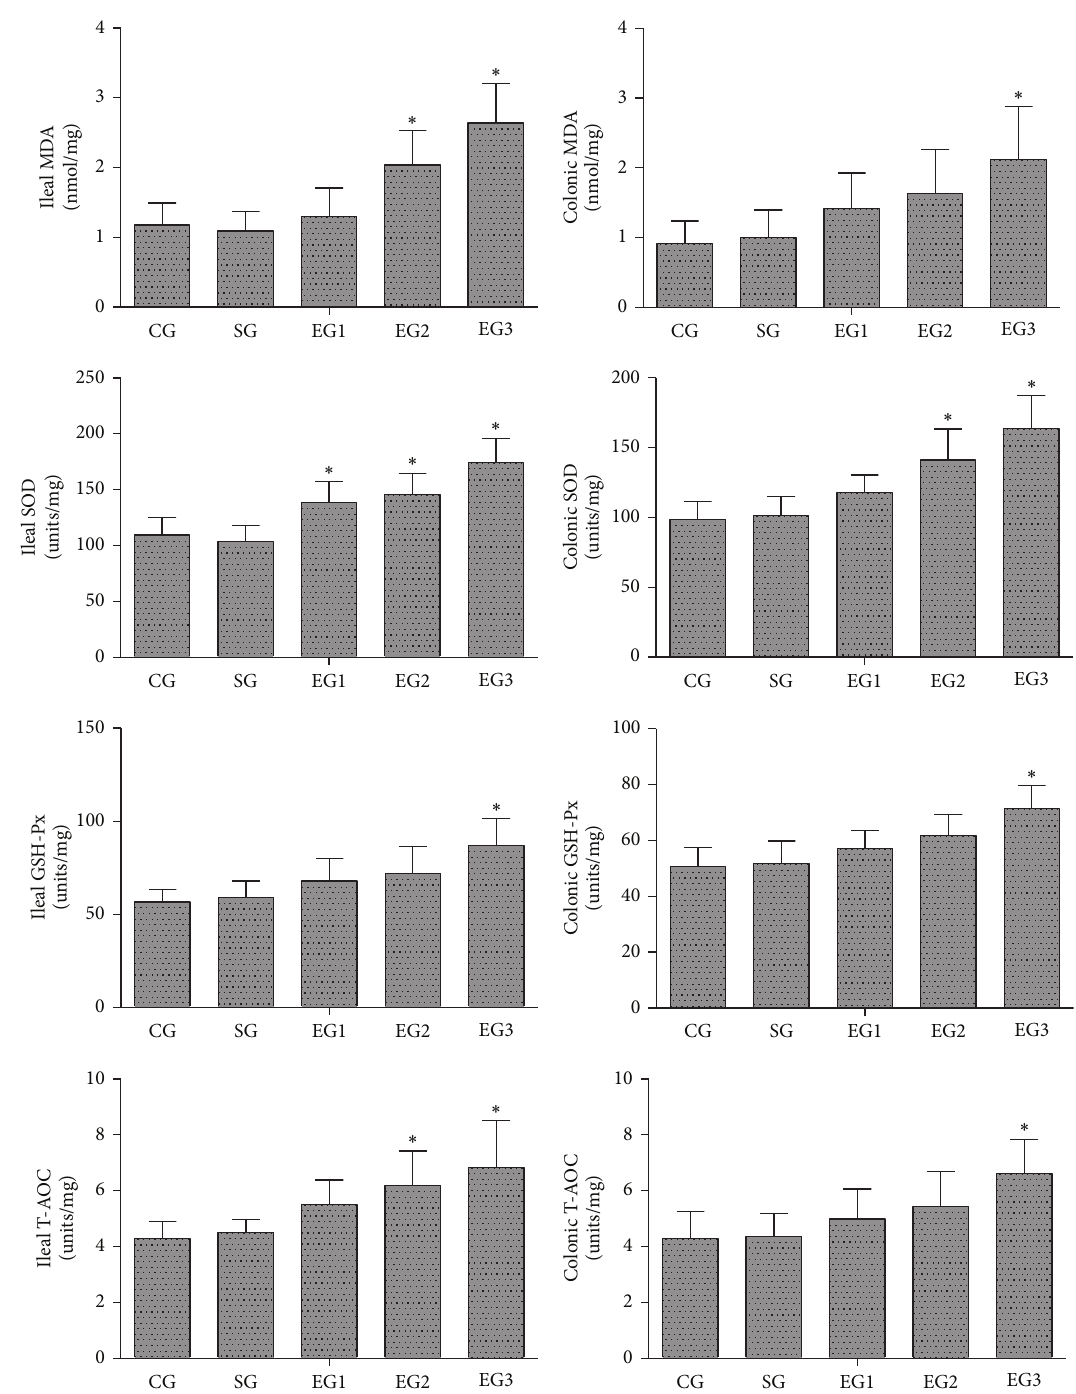
Figure 6: The levels of MDA, SOD, GSH-Px, and T-AOC in the tissues of ileum and colon. CG: control group; SG: sham group; EG1, EG2, and EG3: exposure groups with peritoneal air exposure for 1, 2, and 3h, respectively. Data are expressed as mean ± SD, 𝑛 = 8 . ∗ 𝑃 < 0.05 , versus the CG